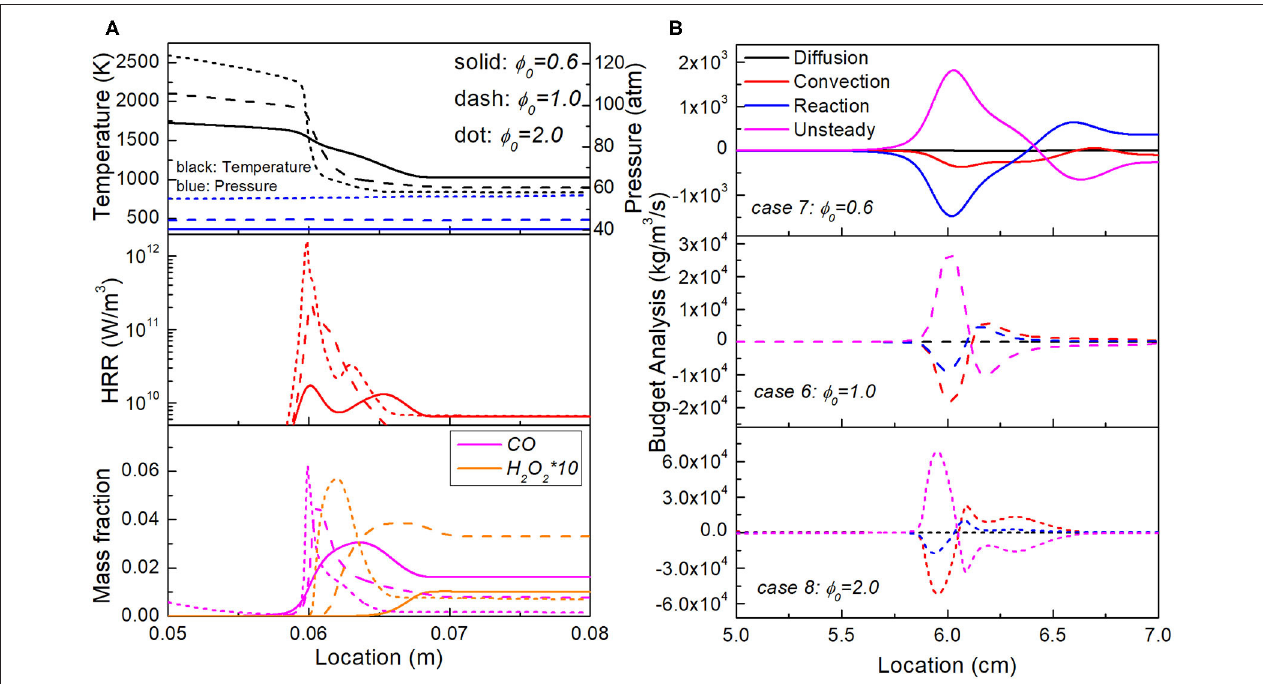
FIGURE 12 | Comparison of the (A) Temperature, pressure, heat release rate and key species fraction profiles and (B) budget analysis of CO mass fraction in Case 6, 7, and 8 with the same lengths of equivalence ratio stratification segment but different φ range.